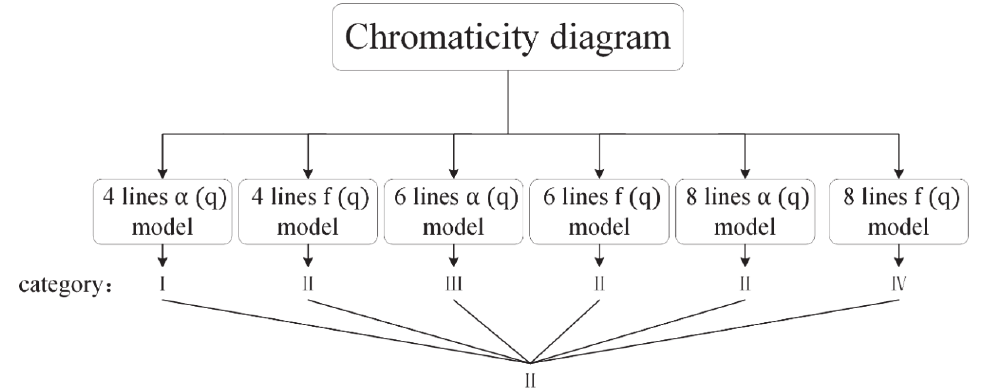
Figure 9. Add the corresponding probabilities to each category, and the category with the max. value is the recognition result.